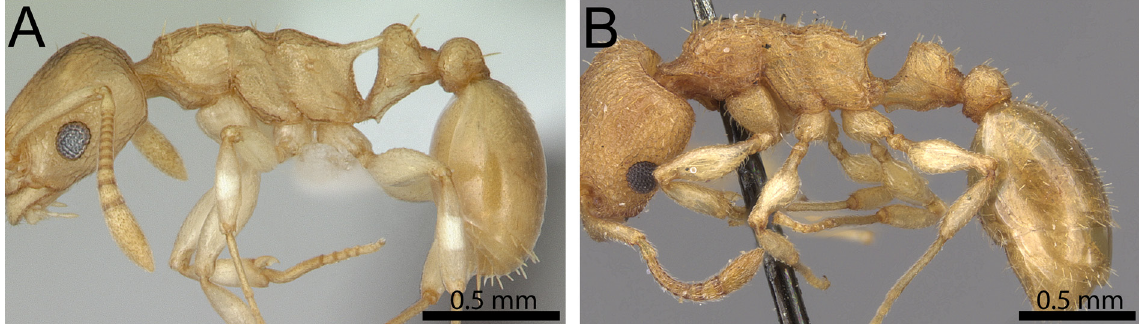
Fig. 10. Body in profile. A . Nesomyrmex evelynae (Forel, 1916) (CASENT0413068). B . N. denticulatus (Mayr,